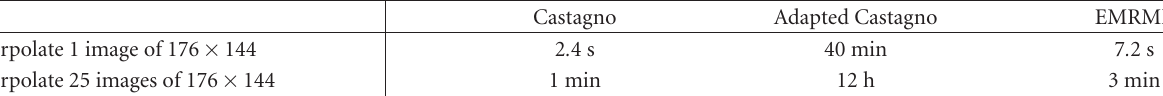
Table 4: Computational load comparison for Pentium Pro II 350 MHz, 256MB